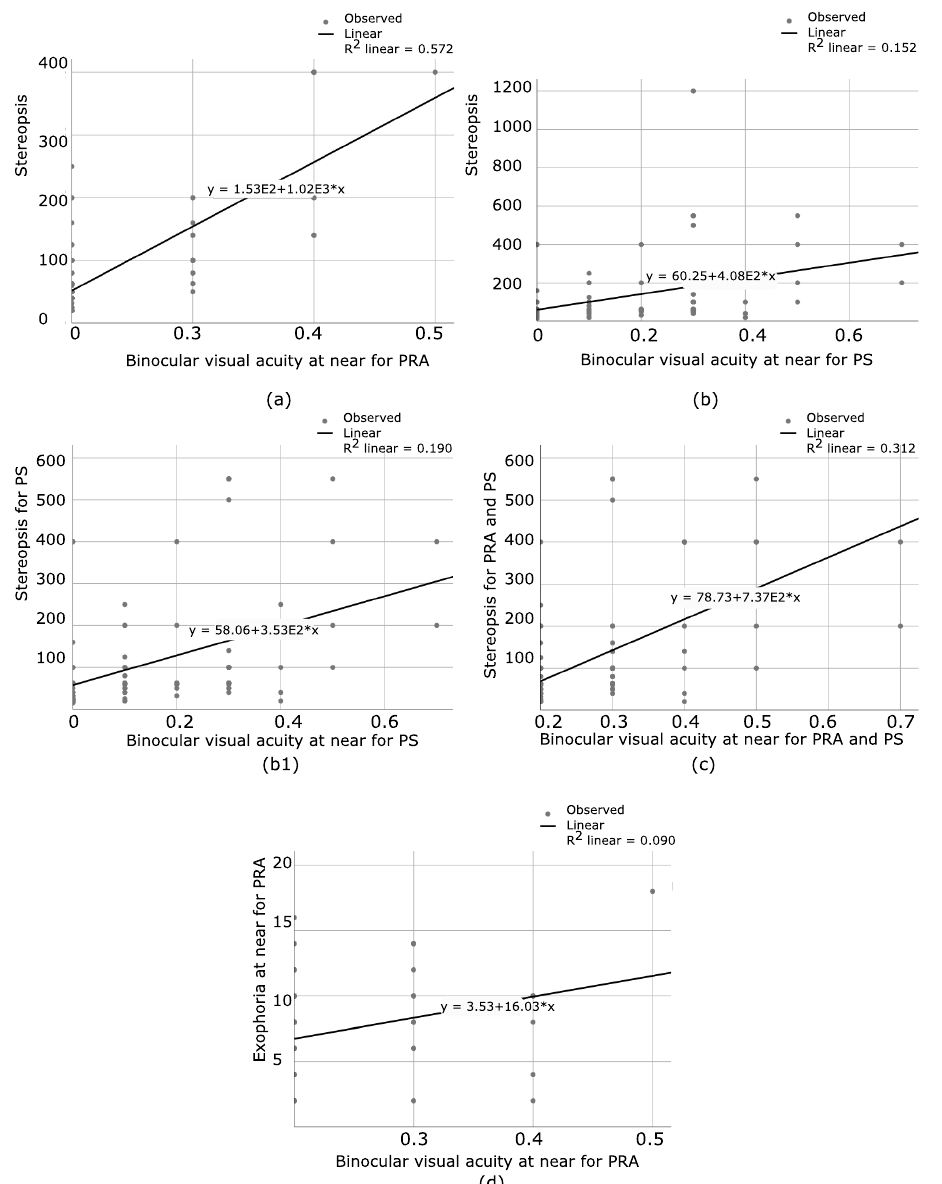
Figure 5. ( a ) Represents the relationship between the degree of stereopsis and the amount of binoc- ular visual acuity at near for PRA. As the visual acuity at near decreases, the degree of stereopsis diminishes. ( b ) The relationship between the degree of stereopsis and the amount of binocular visual acuity at near for PS. Worse stereopsis is obtained in patients with lower visual acuity at near distance. ( b1 ) The relationship between the degree of stereopsis and the amount of binocular visual acuity at near for PS, after excluding the only patients with gross stereopsis. R2 increases, which means that the linear relationship becomes stronger. As visual acuity at near decreases, stereopsis deteriorates. ( c ) The relationship between the degree of stereopsis and the amount of binocular visual acuity at near when PRA and PS with amblyopia and stereopsis were put together. There is an important linear relationship, where patients with worse visual acuity at near obtain lower values of stereopsis. ( d ) Shows the relationship between the amount of binocular visual acuity at near and the exophoria state in PRA. A higher degree of exophoria is obtained in patients with lower visual acuity at near, which clarifies that the phoria state deteriorates as the visual acuity at near